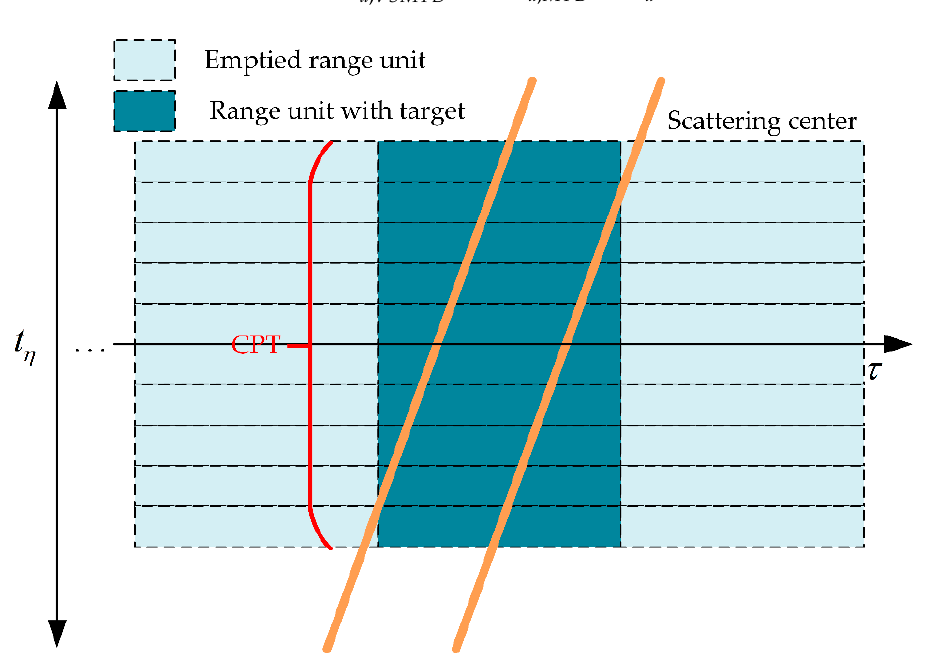
Figure 10. The coherent processing time of VSMTD.